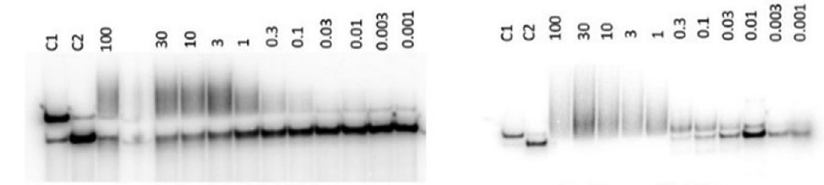
Fig. 3 DNA cross-linking assay for the G-A and G-G DNA cross-linking agents FGX8-46 (6) (Left Panel) and SG3199 (1) (Right Panel). The MS1 DNA sequence 40 was incubated with 0.001 to 100 μ M of either FGX8-46 ( 6 ) or SG3199 ( 1 ) in 10 mM Tris-HCl, 0.1 mM EDTA, at pH 7.5 overnight (37 °C). Tracks labelled C1 are dsDNA control lanes in which DNA was not incubated with 6 or 1 . Tracks labelled C2 are control lanes in which DNA was denatured by treating with formamide and then heated to 65 °C for 5 min in the absence of 6 or 1